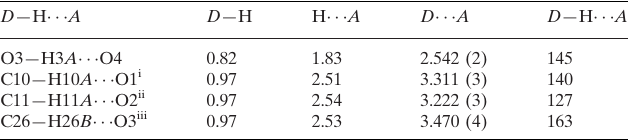
Hydrogen-bond geometry (A˚ , (cid:4)